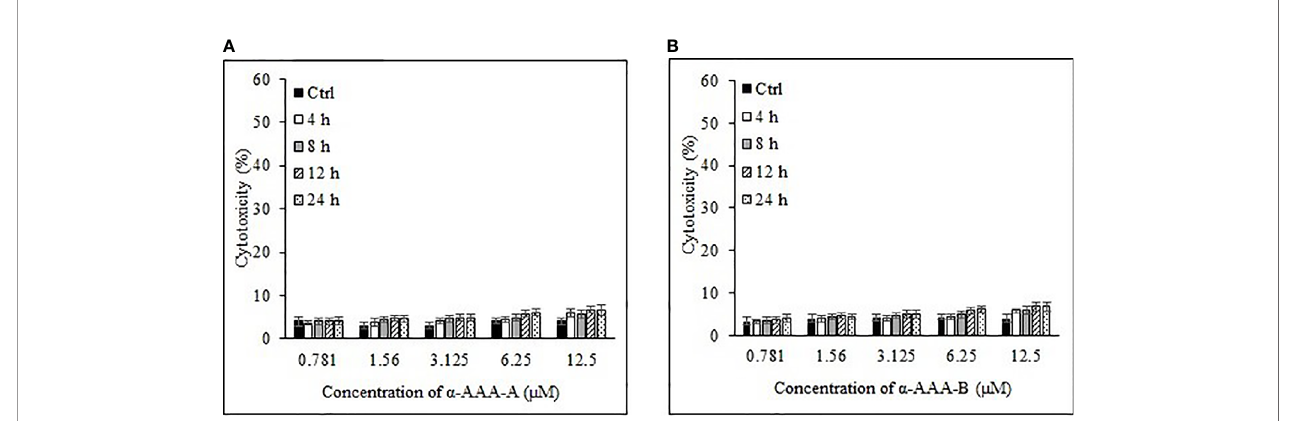
FIGURE 5 | Analysis of normal breast cell line MCF10A cytotoxicity by a -AAA-A (A) and a -AAA-B (B) at different concentrations and time durations of incubation. Control means MCF10A cells without molecules served